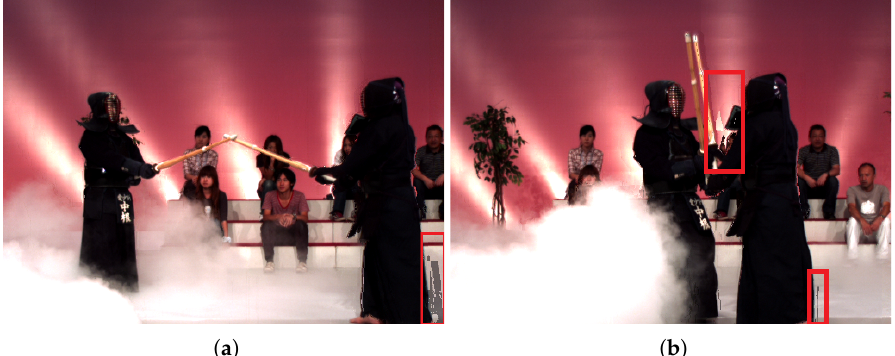
Figure 1. Effect of inaccurate depth maps on the depth-image-based rendering (DIBR)-synthesized images. ( a ) Occluded regions becoming visible in the synthesized image and generating holes highlighted in red rectangles, ( b ) structural distortions in the synthesized view distorting the face of a